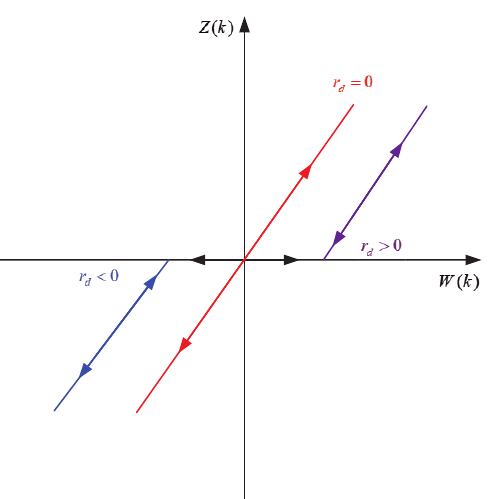
Figure 3. The play operator.